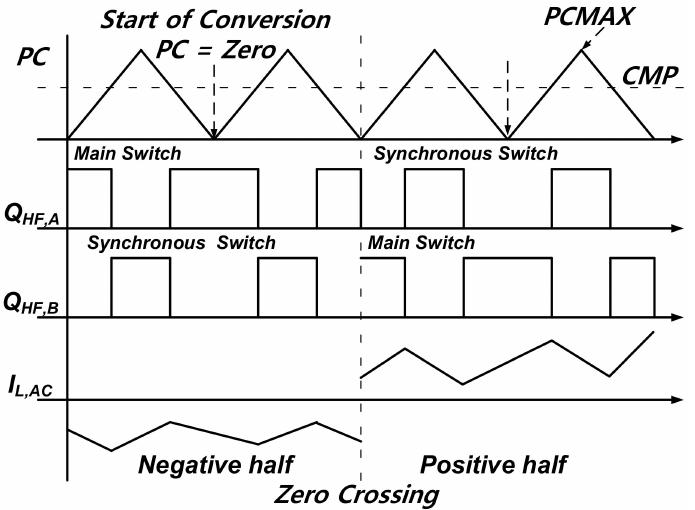
Figure 6. Action qualifier setting by polarity change for constant start of conversion (SOC).